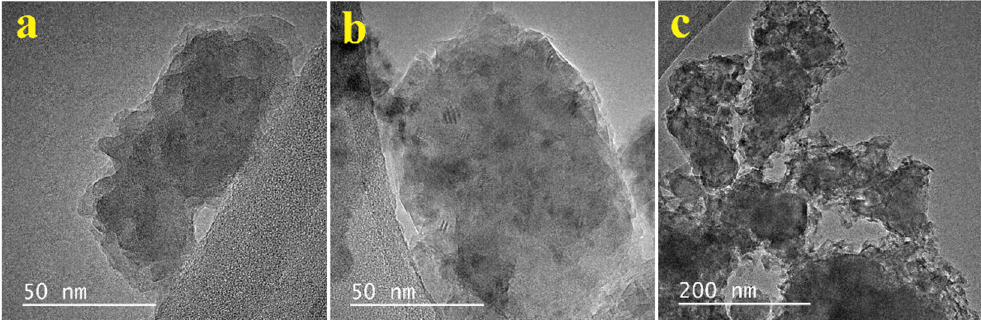
Figure 1. TEM images of ( a ) HA, and ( b ) ZnHA nanoparticles showing flake-like morphology, and ( c ) ZnHA-rGO showing ZnHA nanoparticles composited with rGO sheets.